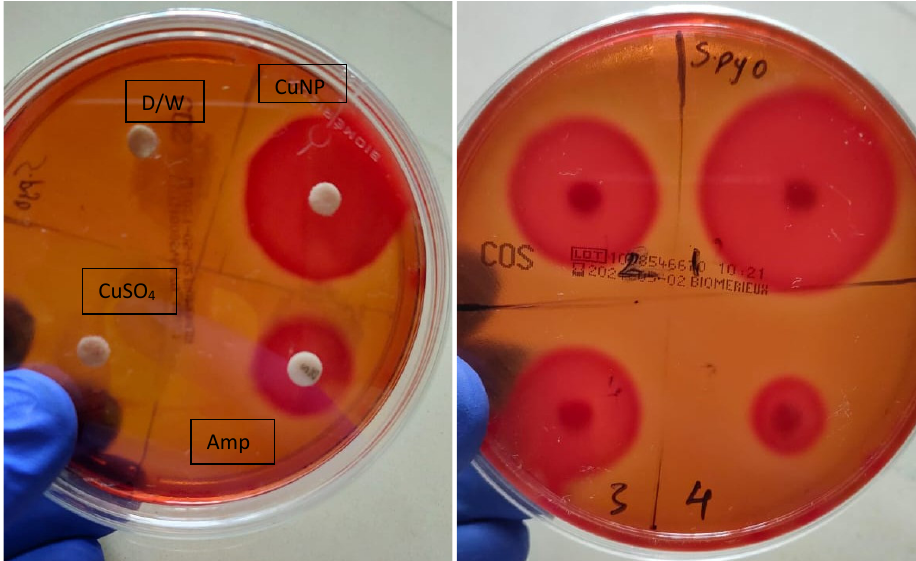
Fig. 10A. & Fig. 10B. Antimicrobial sensitivity of Streptococcus pyogenes